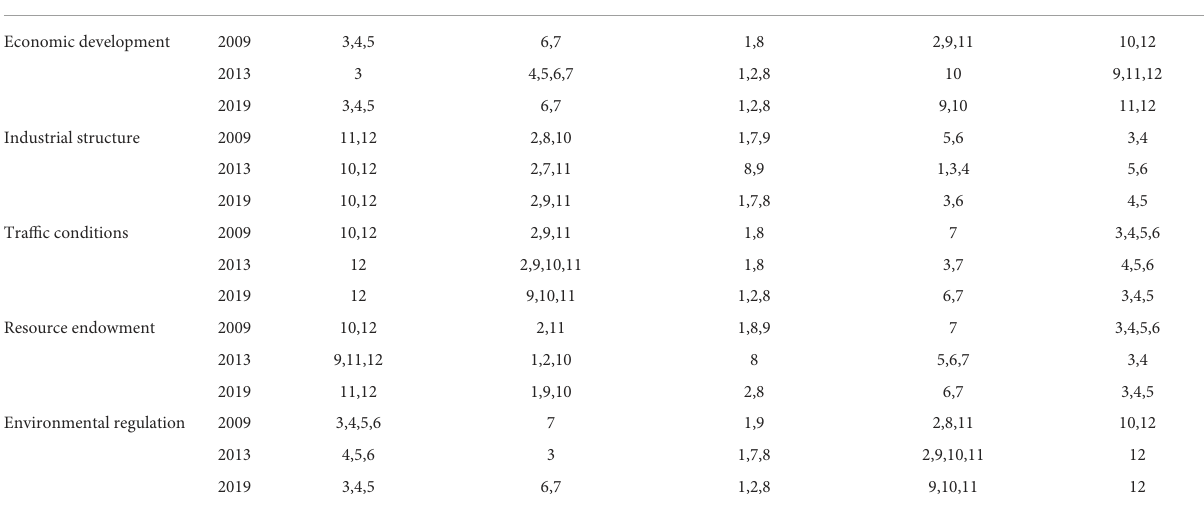
TABLE 4 Natural fault zone division of each parameter in the geographically weighted regression (GWR) model. Year High-value area Re-High-value area Median value area Re-Low-value area Low-value